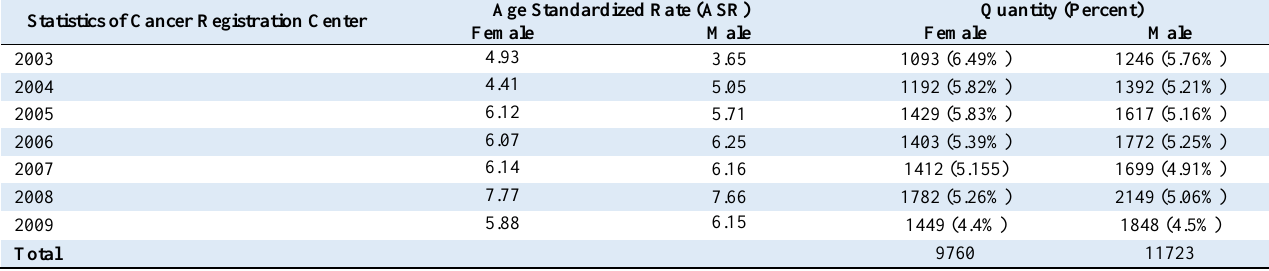
Table 1. Occurrence of esophageal cancer in Iran based on statistics from Cancer Registration Center Age Standardized Rate Statistics of Cancer Registration Center